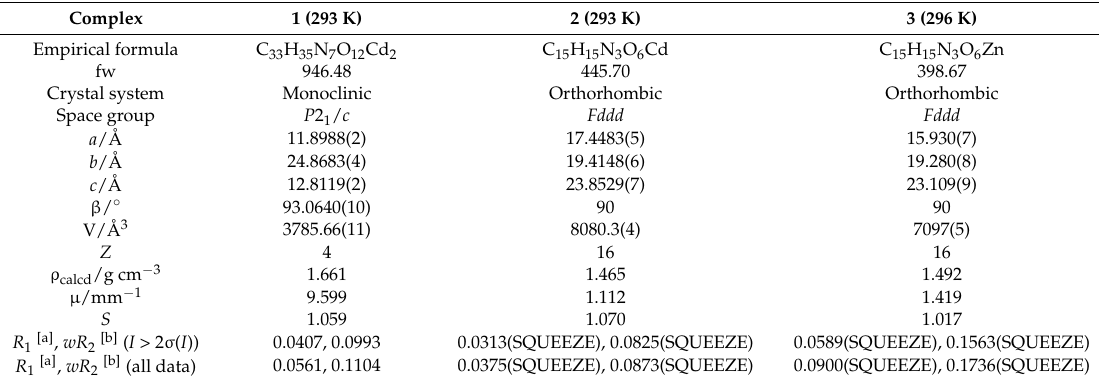
Table 1. Crystal data and structure refinements for 1 – 3